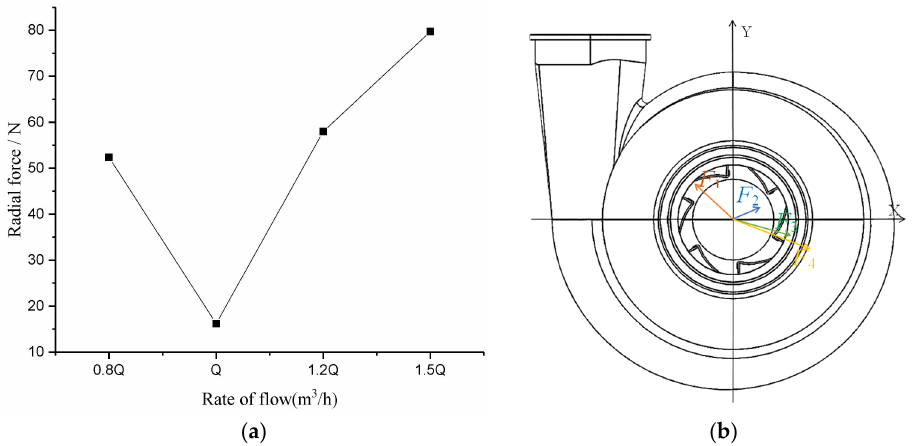
Figure 10. Steady radial force distribution under different working conditions; ( a ) radial force size change; ( b ) radial force direction.